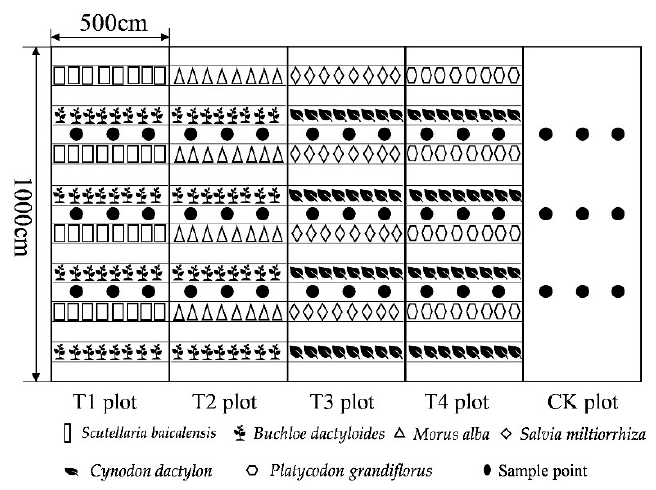
Figure 7. Schematic diagram of sampling points in runoff plots. Table 4. Hedgerow patterns in different runoff plots.